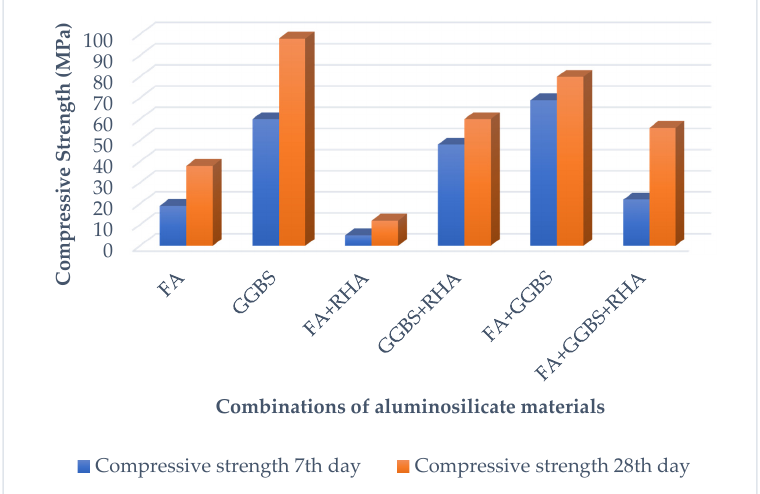
Energies 2023 , 16 , x FOR PEER REVIEW Figure 5. Influence of different precursors on compressive strength of AAC [99] .